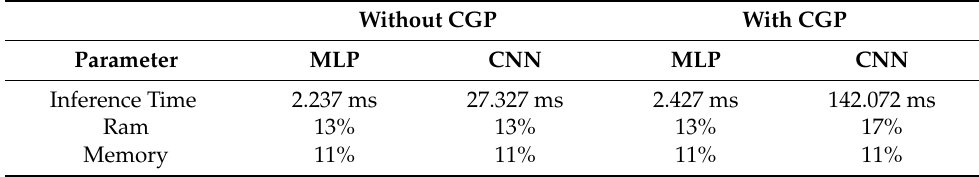
Table 5. Microcontroller neural network